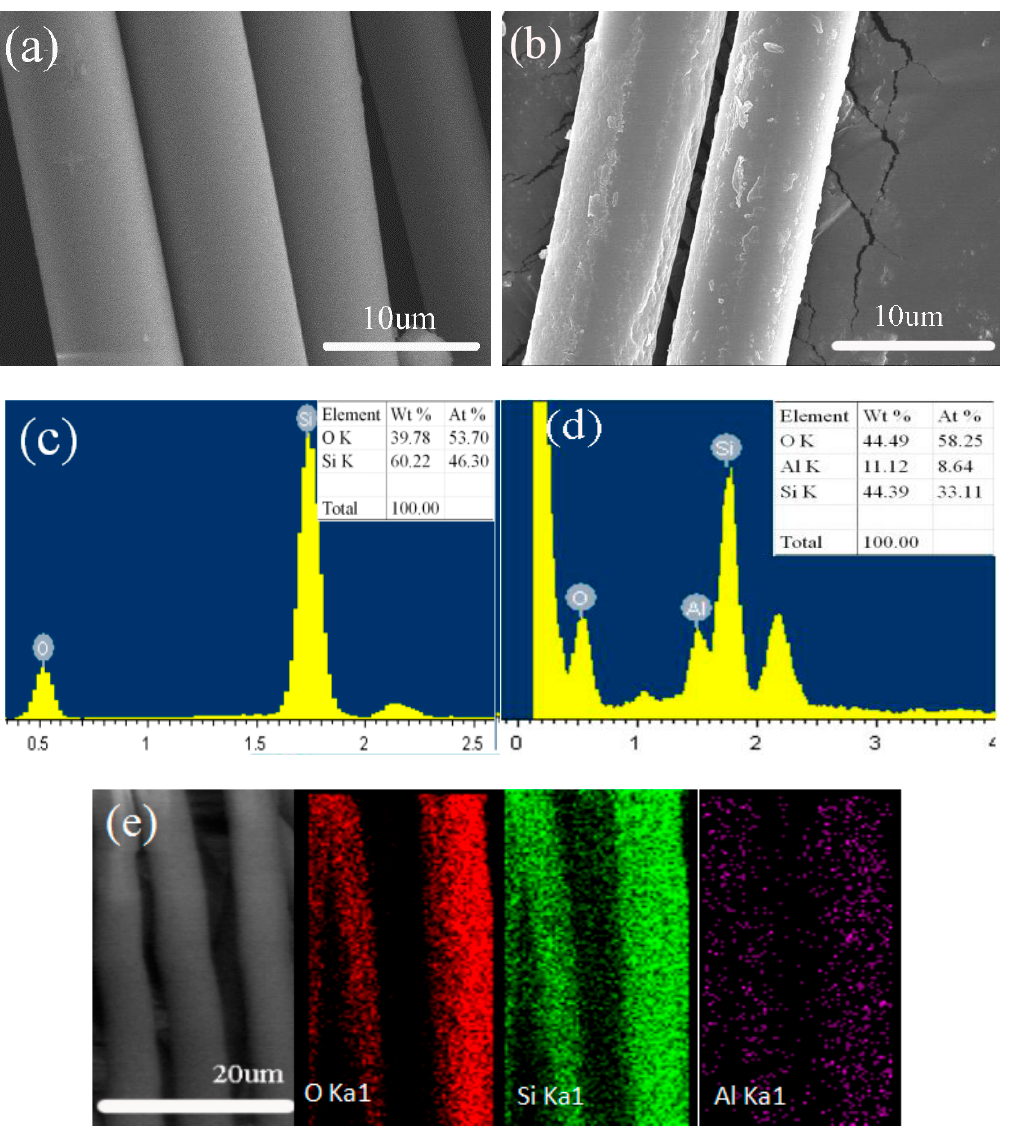
Figure 2. SEM morphologies ( a , b ), energy disperse spectroscope spectra ( c , d ) and mapping results ( e ) of the bare ( a , c ) and coated quartz fibers ( b , d , e ).